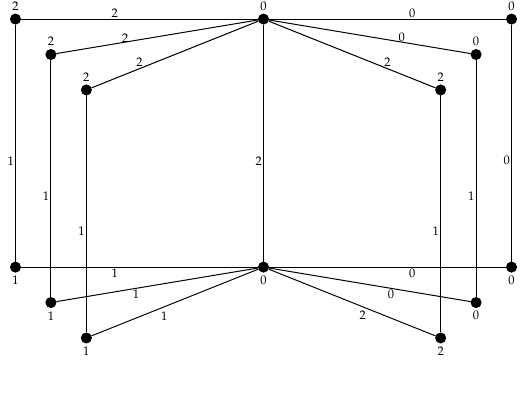
Figure 7. 3-TEPC labeling of B